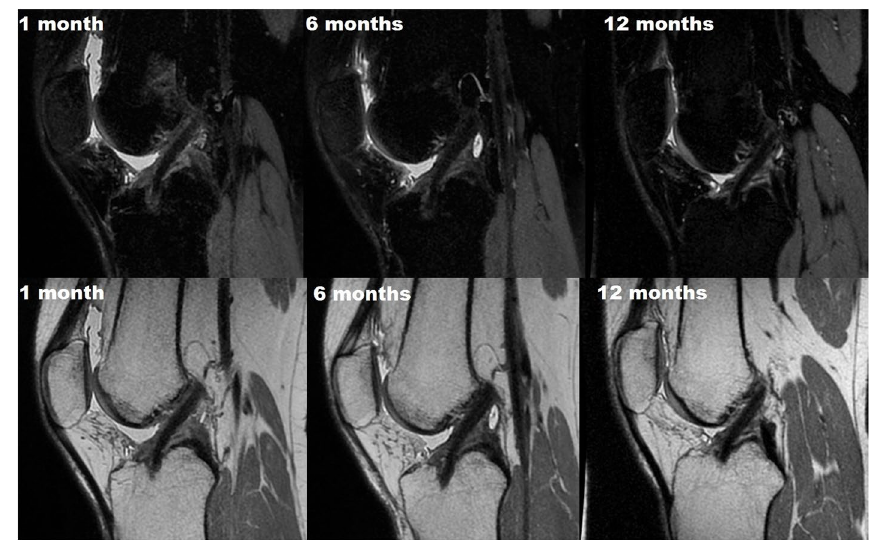
Fig. 6 MRI of hamstring ACL graft that was harvested preserving the distal portion 1, 6, and 12 months after